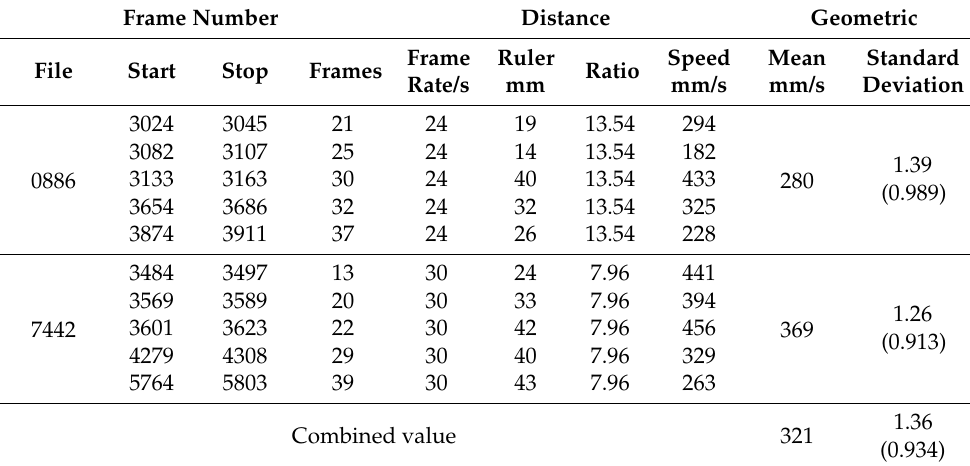
Table 6. Upward air motion in an open